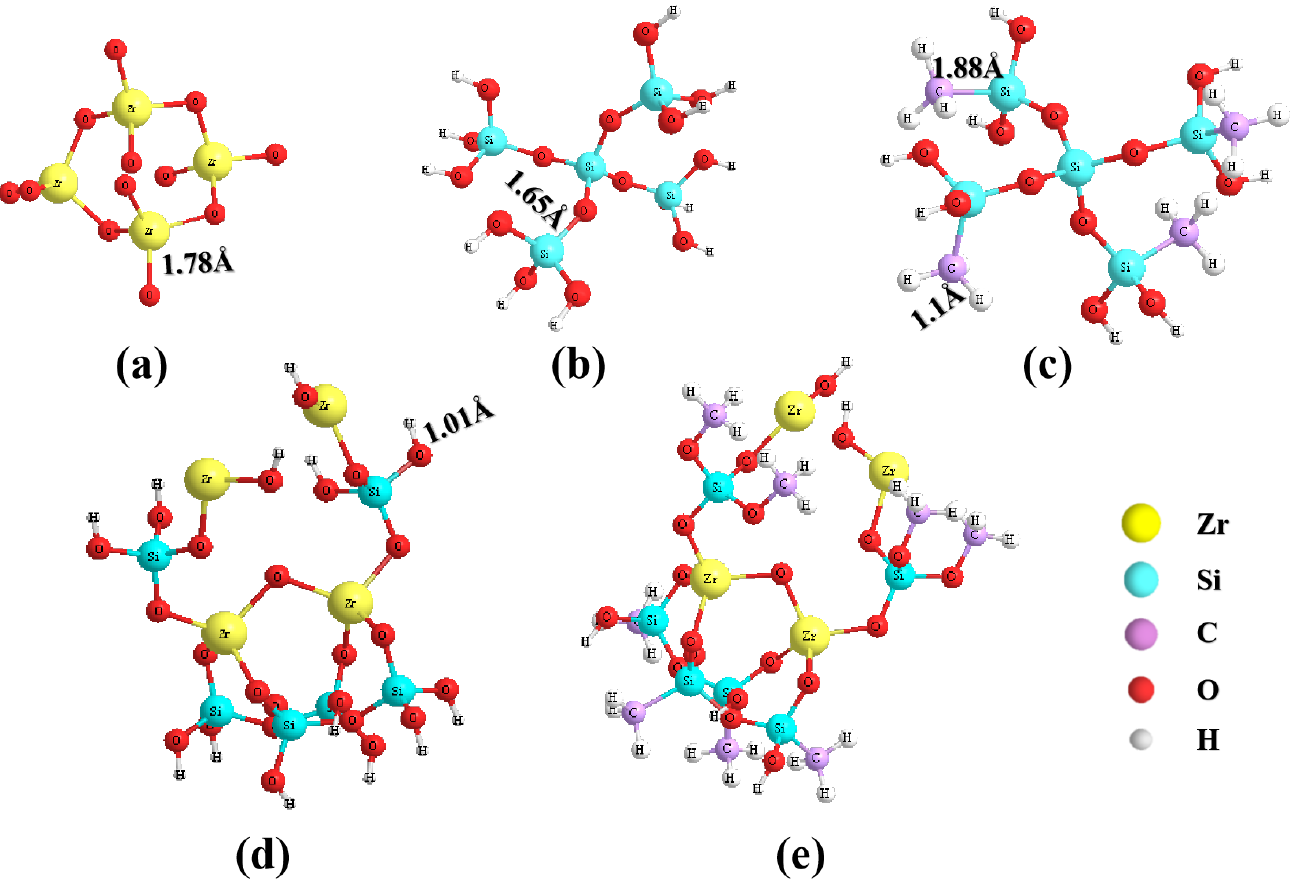
Figure 5. Molecular structural models of ( a ) ZrO 2 , ( b ) hydrophilic SiO 2 , ( c ) hydrophobic SiO 2 , ( d ) hydrophilic ZrO 2 -SiO 2 , and ( e ) hydrophobic ZrO 2 -SiO 2 xerogels. The pore structure parameters of hydrophilic and hydrophobic ZrO 2 -SiO 2 xerogels are shown in Table 1. The average pore size, BET surface area, and total pore volume of hydrophobic ZrO 2 -SiO 2 xerogel are larger than those of hydrophilic ZrO 2 -SiO 2 xerogel. Compared with the hydrophilic ZrO 2 -SiO 2 xerogel, the specific surface area and pore capacity of the hydrophobic ZrO 2 -SiO 2 xerogel sample increased by 62.76% and 59.26%, respectively. Generally speaking, the adsorption performance of an adsorbent depends mainly on its surface properties and the BET surface area, whereas a larger BET surface area and a suitable pore size are more favorable [27] for the adsorption of dye molecules. The hydrophobic xerogel was more